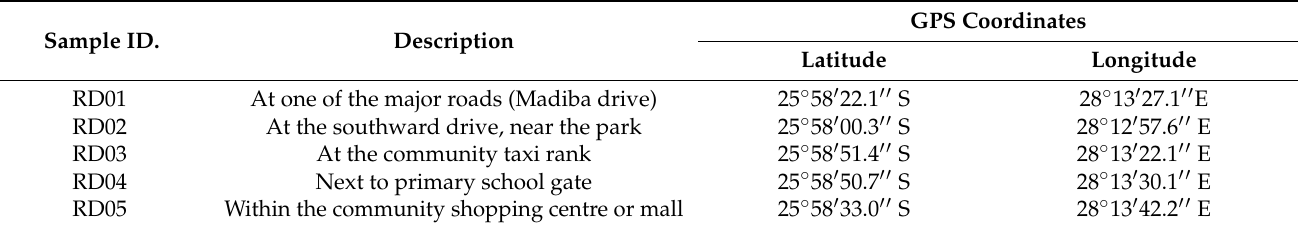
Table 1. Location and characteristics of sampling